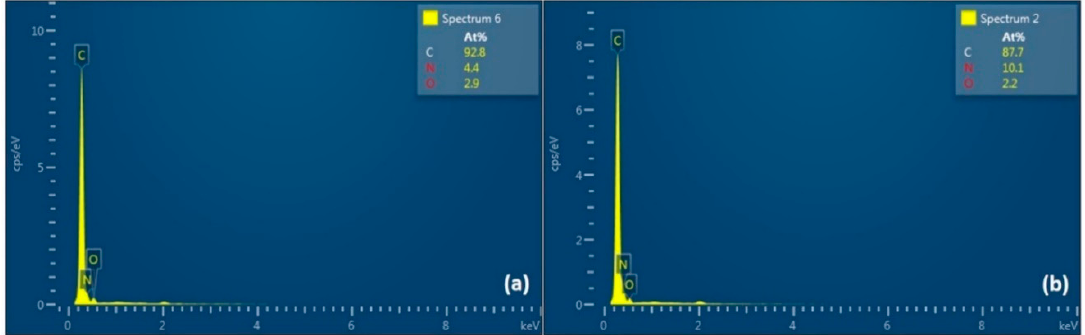
Figure 5. FESEM micrographs of NF, rGO/NF0.1 and rGO/ACNF0.1 composite at different magnifications ( a – c ) of 1000× magnification and ( d – f ) of 20,000× magnification.